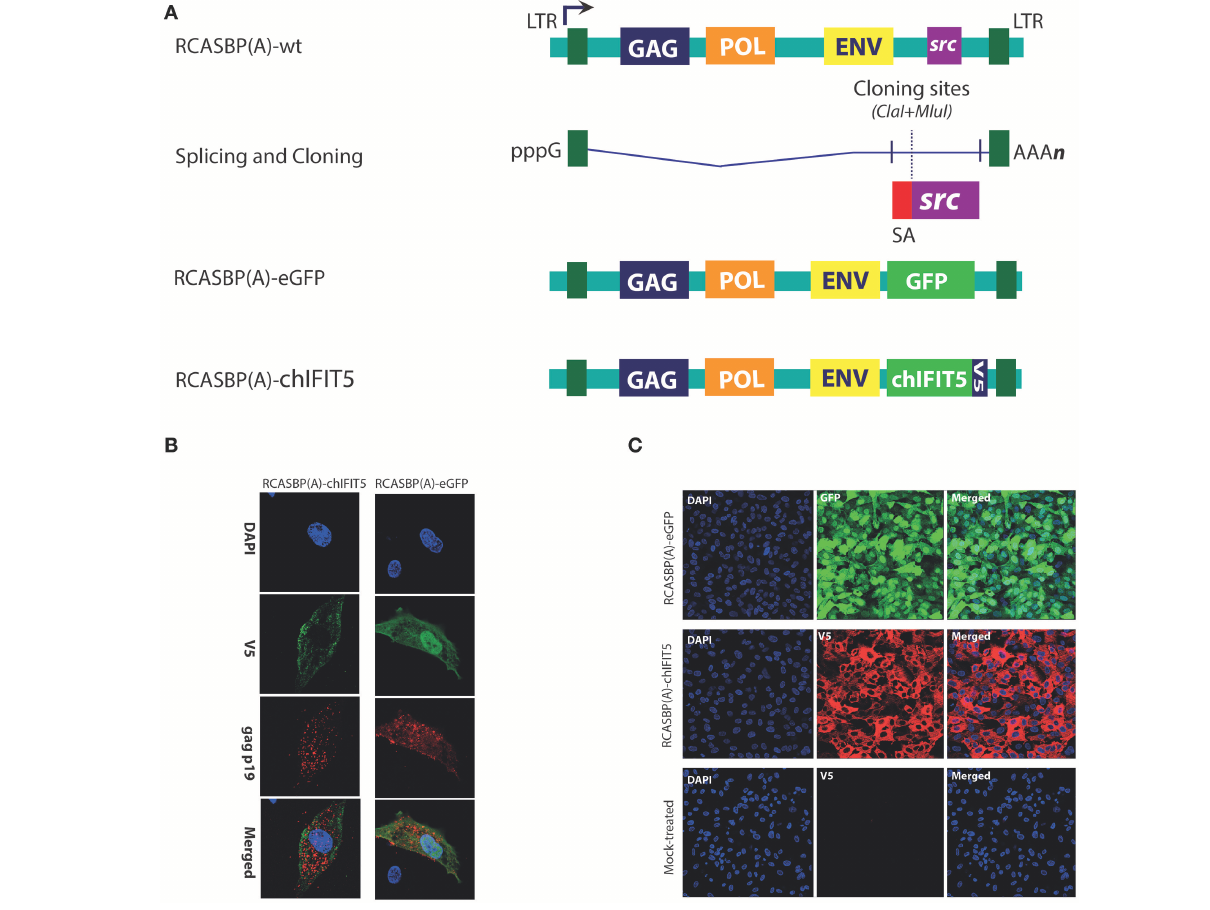
Frontiers in Immunology |